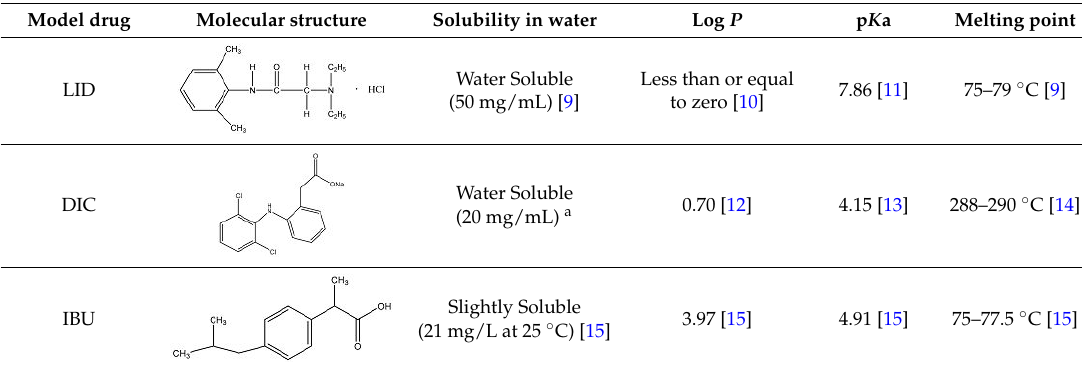
Table 1. Physicochemical properties of model